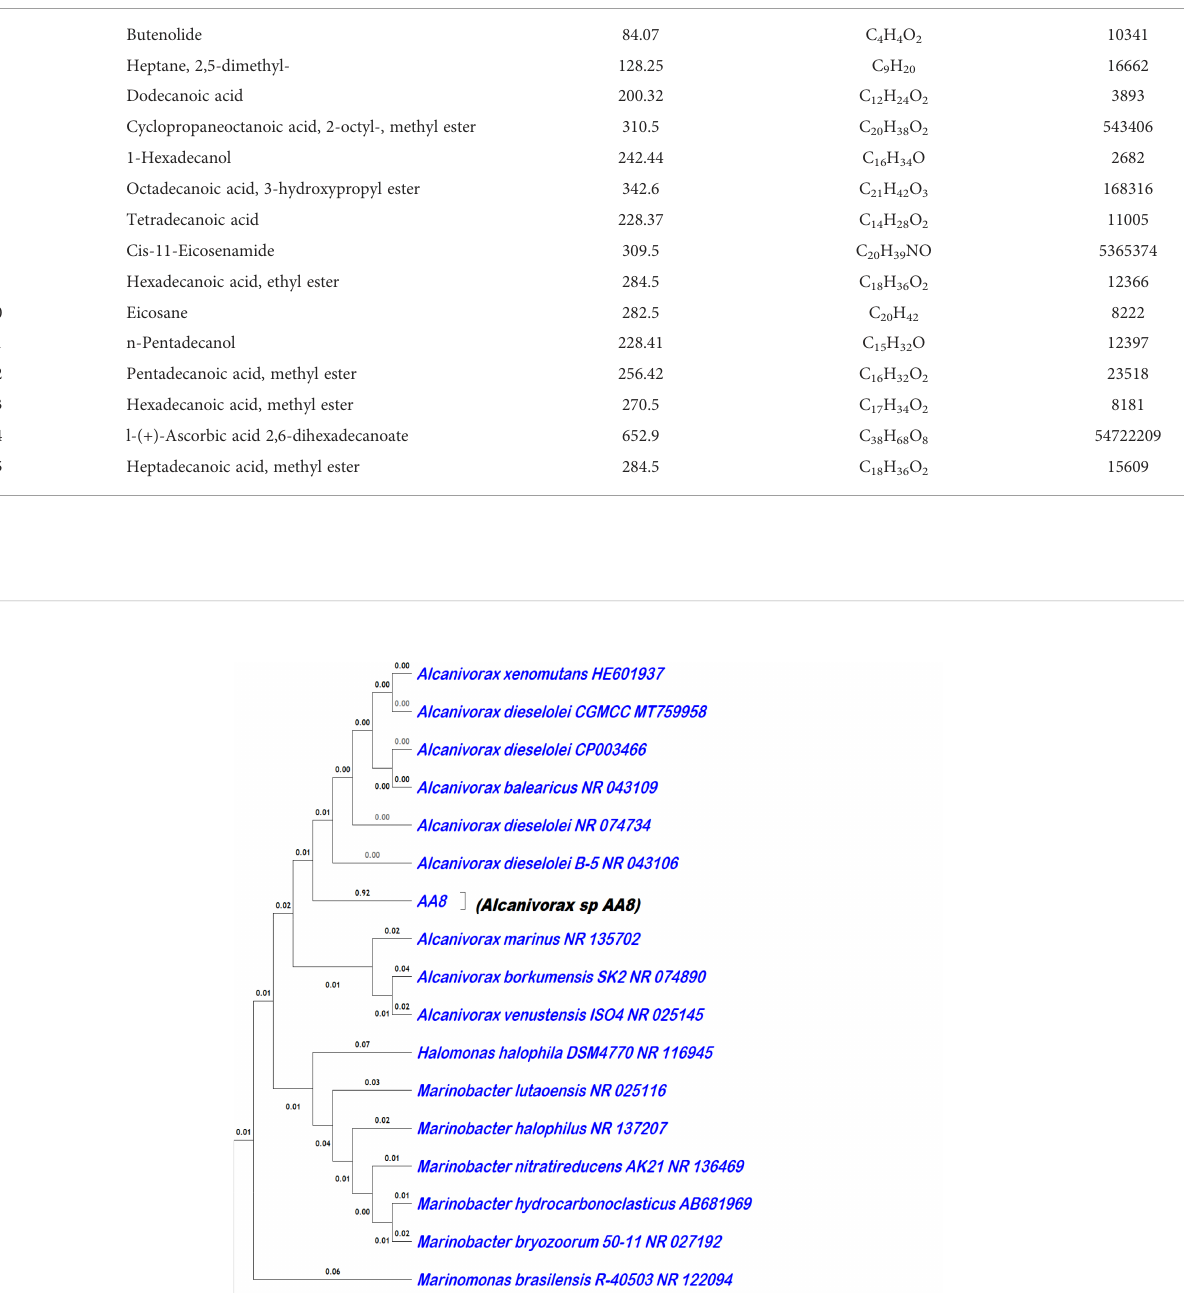
TABLE 1 Details of the ligands (reference compound and the compounds identi fi ed from the extract of the bacterium Alcanivorax sp. AA8) downloaded from PubChem. S.